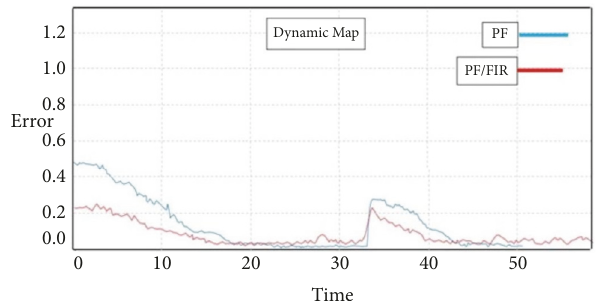
Figure 11: Position errors of PF and hybrid (PF/FIR) filters in a dynamic environment.